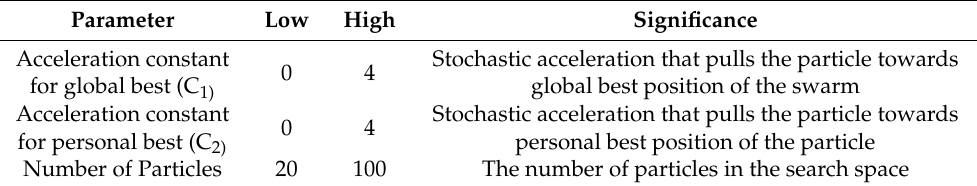
Table 1. Summary of PSO parameters